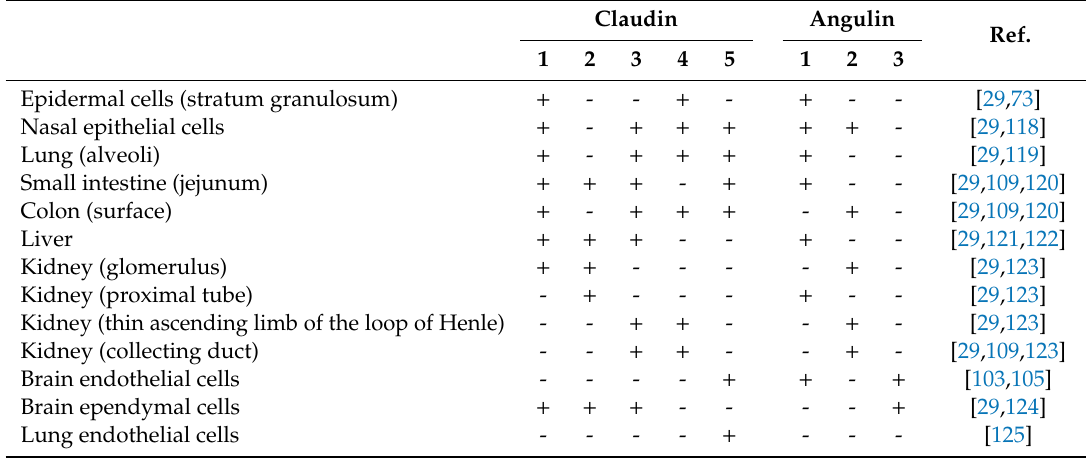
Table 4. Claudin and angulin expression in representative tissues in a mouse or